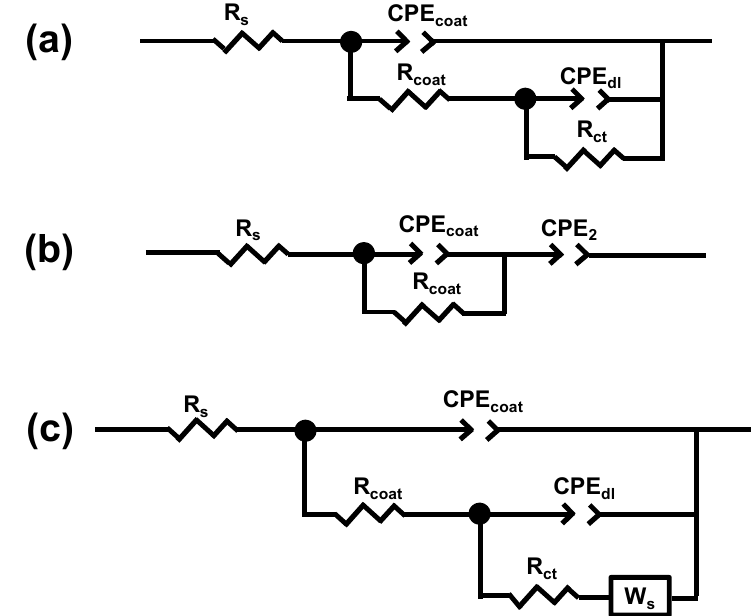
Figure 13. Equivalent circuits ( a – c ) used for fitting and modeling the experimental impedance data.